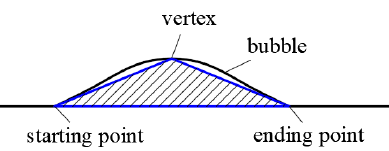
Figure 8. The position relationship of bubble starting point, ending point, and vertex.